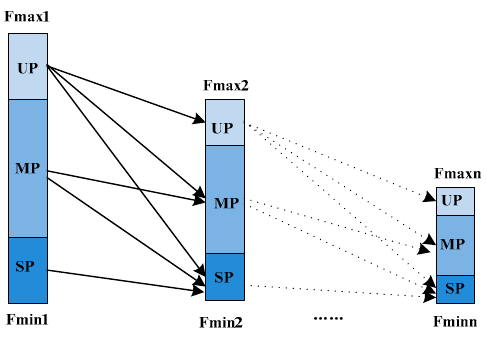
Figure 3. A phase transition from an unstable phase to a stable phase.